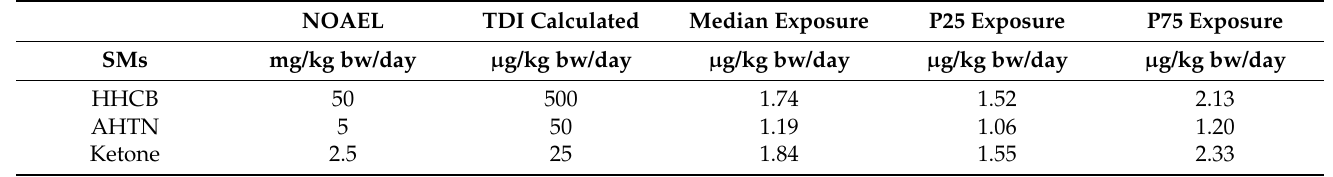
Table 4. NOAEL values and the estimated exposure to detected SMs from shrimp consumption among the Por- tuguese